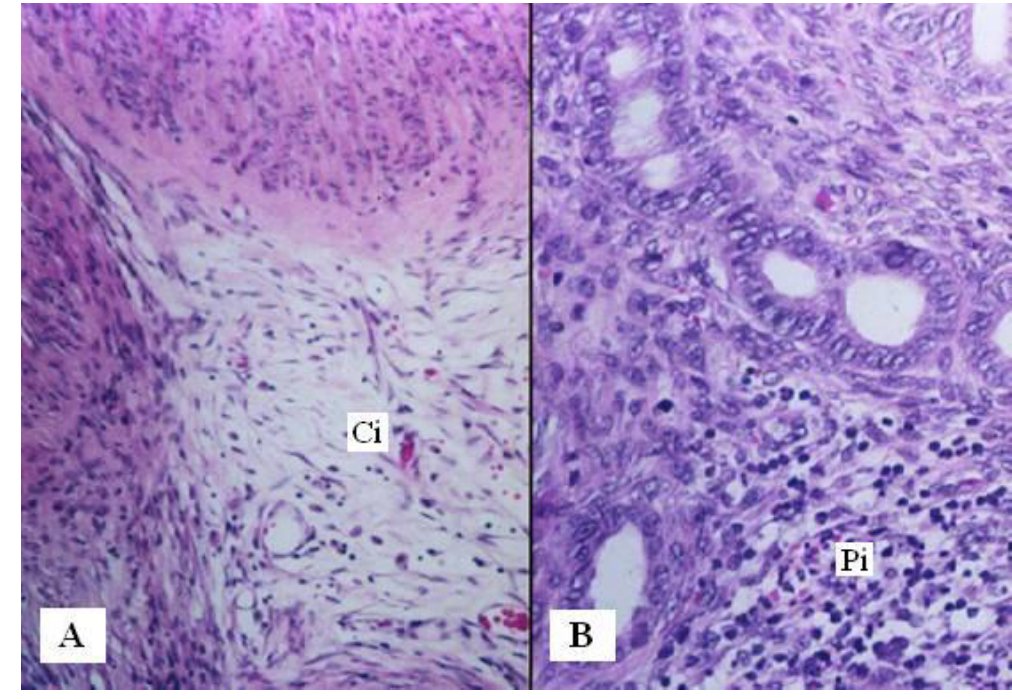
Figure 1. Microscopic aspect of the uterus 7 days after surgery- A = exudative phase, (Ci). B = inflammatory cells in G exuberant healing in G 2 Staining HE